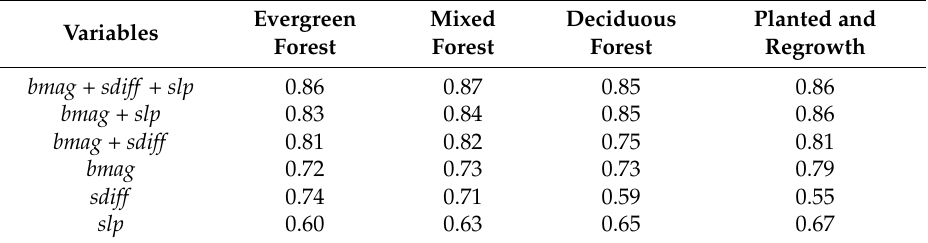
Figure C2. Receiver operating characteristic (ROC) curves for models using different explanatory variables and combinations of variables derived from EVI time series. Panels represent forest type: evergreen forest ( a ); mixed forest ( b ); dry-deciduous forest ( c ); and planted forest and regrowth ( d ). Table C2. Area under curve (AUC) estimates for regression models using EVI and different combinations of parameters, by forest type. AUCs for each model are derived using receiver operating characteristic (ROC) curves presented in Figure C2.